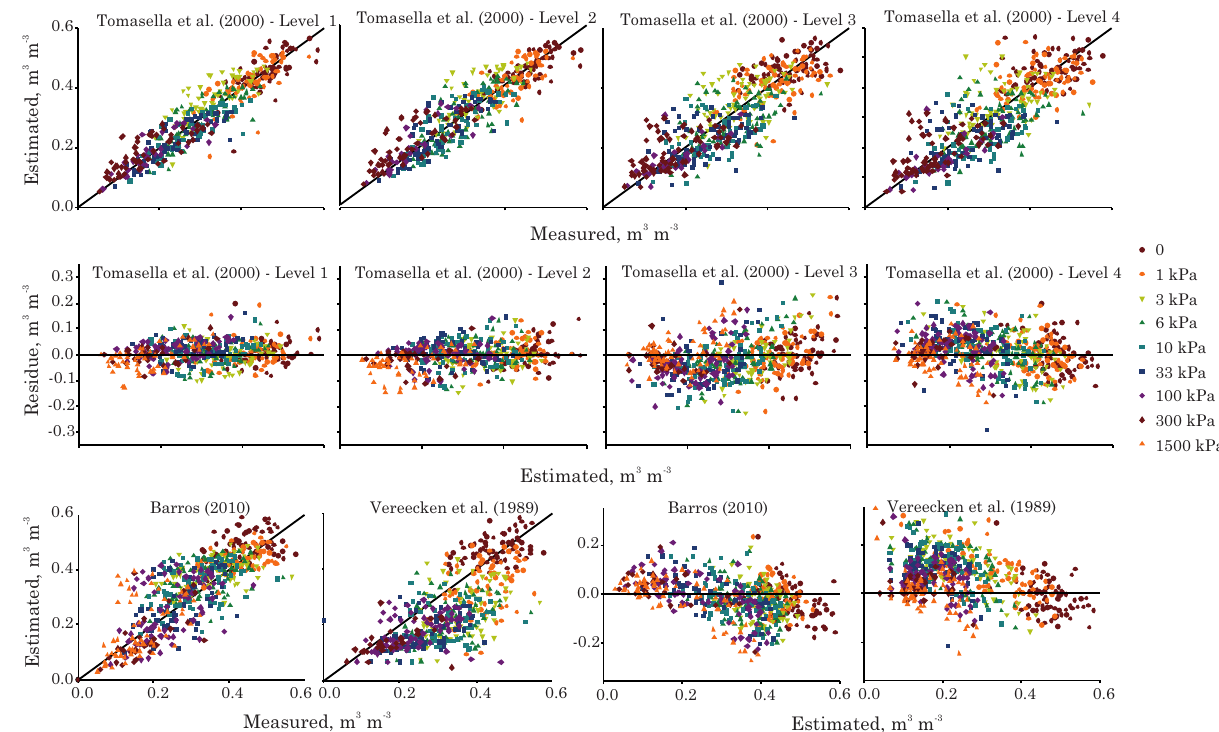
Figure 3. Estimated vs measured volumetric water content, and estimation residues for the parametric PTFs tested for all depths (n =